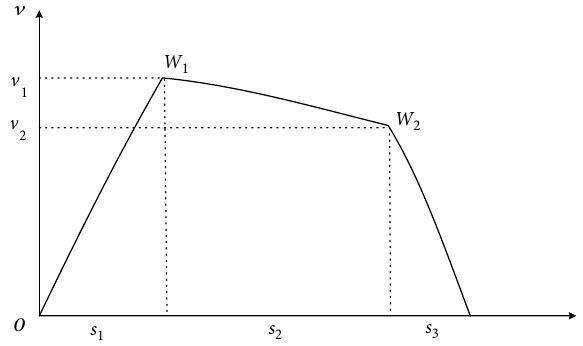
Figure 1: The v – s curve of train operations between